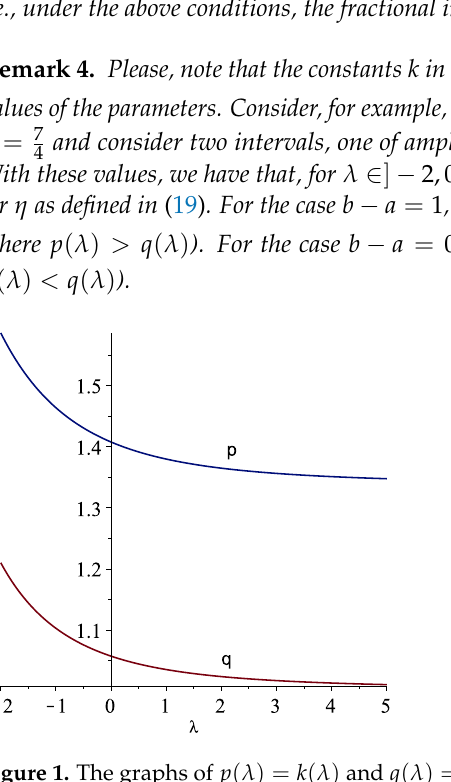
Figure 1. The graphs of p ( λ ) = k ( λ ) and q ( λ ) =